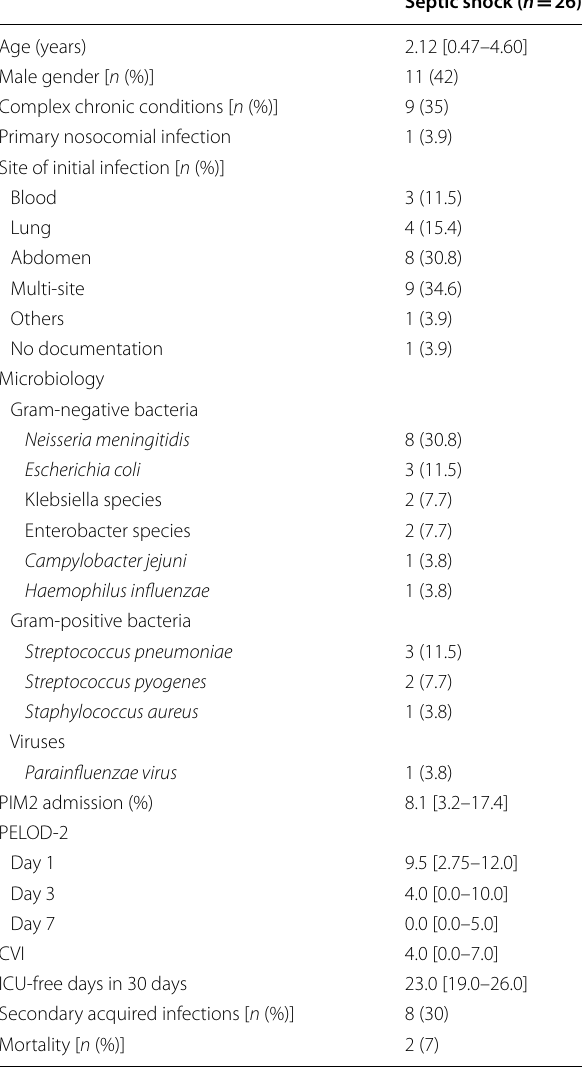
Table 1 Characteristics of the 26 children with septic shock included in the